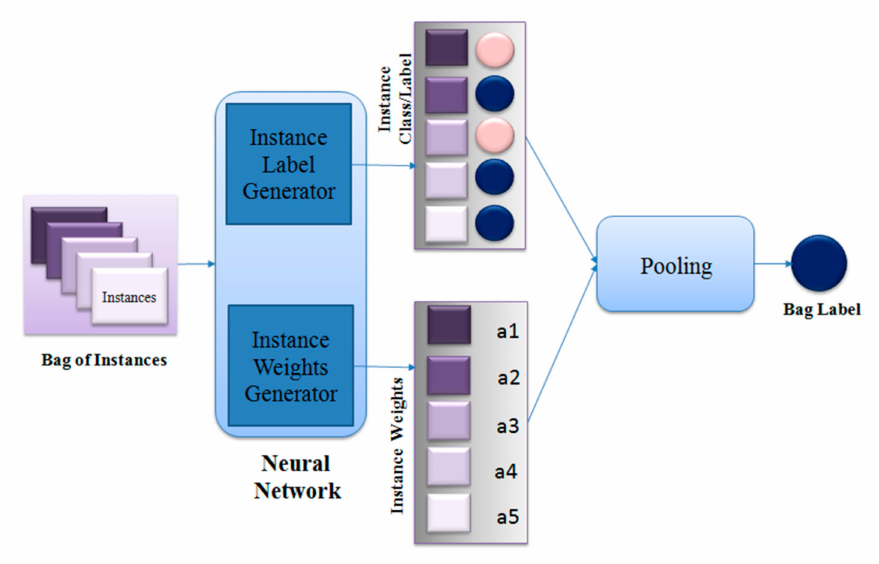
Figure 3. Attention-based pooling functions.